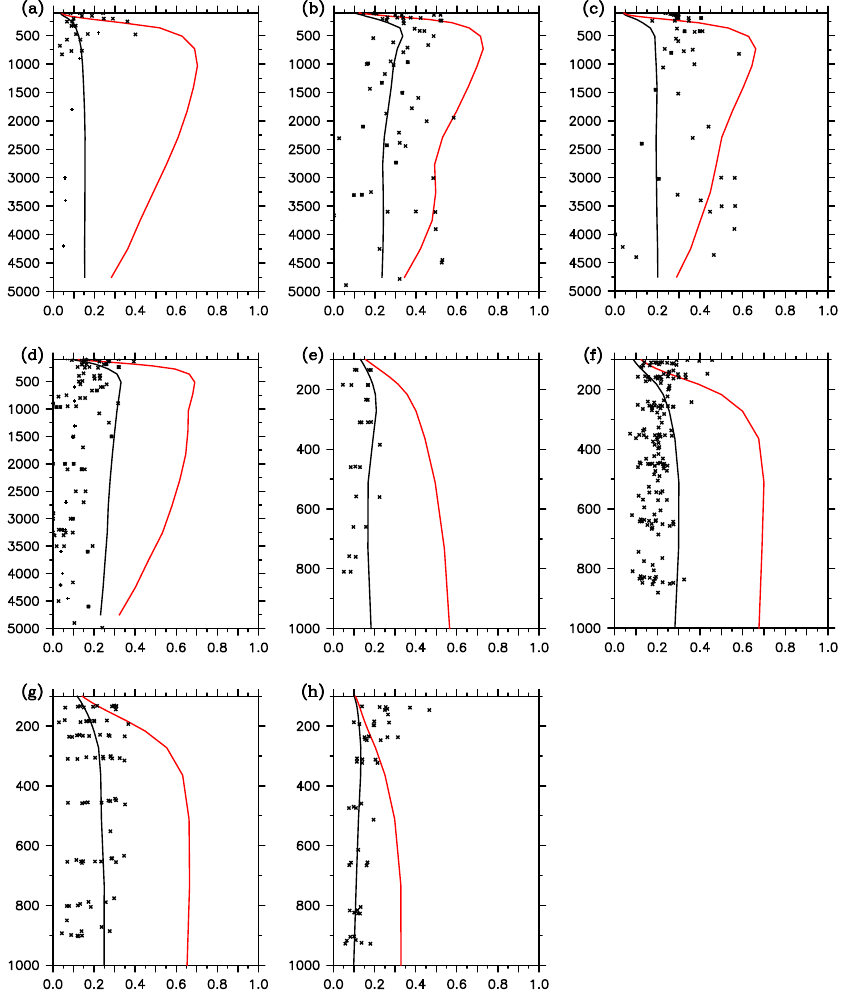
Figure 5. The modelled and observed relative contributions of large POC to total POC concentration (bPOC / (sPOC + bPOC), in µM) in different regions of the ocean: (a) western, (b) oligotrophic, and (c) eastern North Atlantic Ocean; (d) Hawaii; (e) northwest, (f) northeast, (g) central, and (h) southern Pacific Ocean. Solid lines denote concentrations averaged over the regions marked by the blue and green rectangles on the map of Fig. 3: without (in red) and with the reactive continuum (RC) parameterisation (in black). The black speckles are observations in the respective regions from Druffel et al. (1992) and Lam et al. (2011,